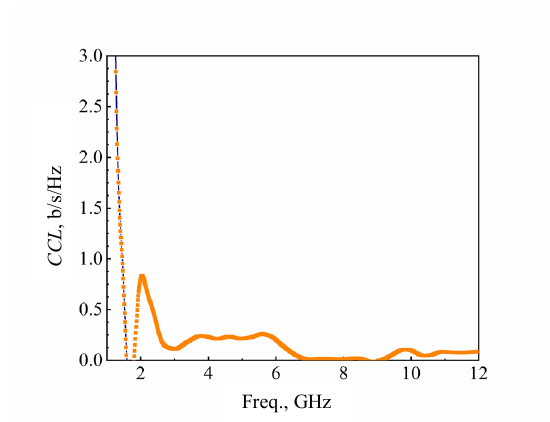
Fig. 13. CCL of UWB/MIMO antenna system.